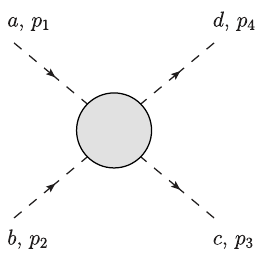
Figure 2 . Assignment of momenta and group indices for the scattering amplitude